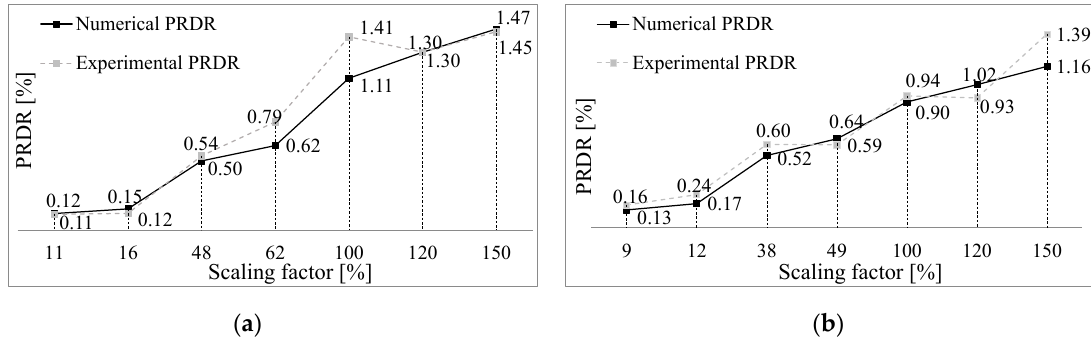
Figure 9. Comparison between experimental and numerical peak roof drift ratio (PRDR). ( a ) Type 1 mock-up; ( b ) Type 2 mock-up.